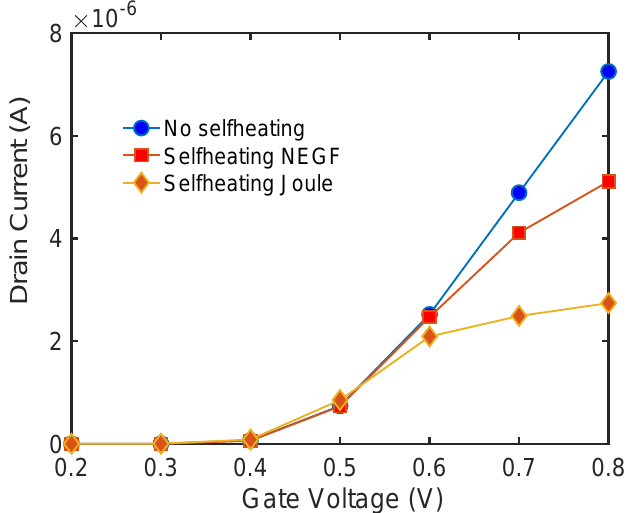
Figure 7. Transfer characteristic for cases (i) no self-heating (NSH), (ii) hot electrons self-heating (HSH) and (iii) Joule self-heating (JSH). In the no self-heating case the lattice is keeped at 300 K. In the other cases the local lattice temperature depend on the net power dissipated by the electron system locally to the phonon system. For the case (iii), the electron system is considered at local equilibrium with the lattice. The drain bias is Vd = 0.6 V. At high gate bias, the current for the of Joule selfheating is larger than the current for the hot electron one, this is a consequence of the higher temperature of the lattice for the joule case as compared to the hot electron case.